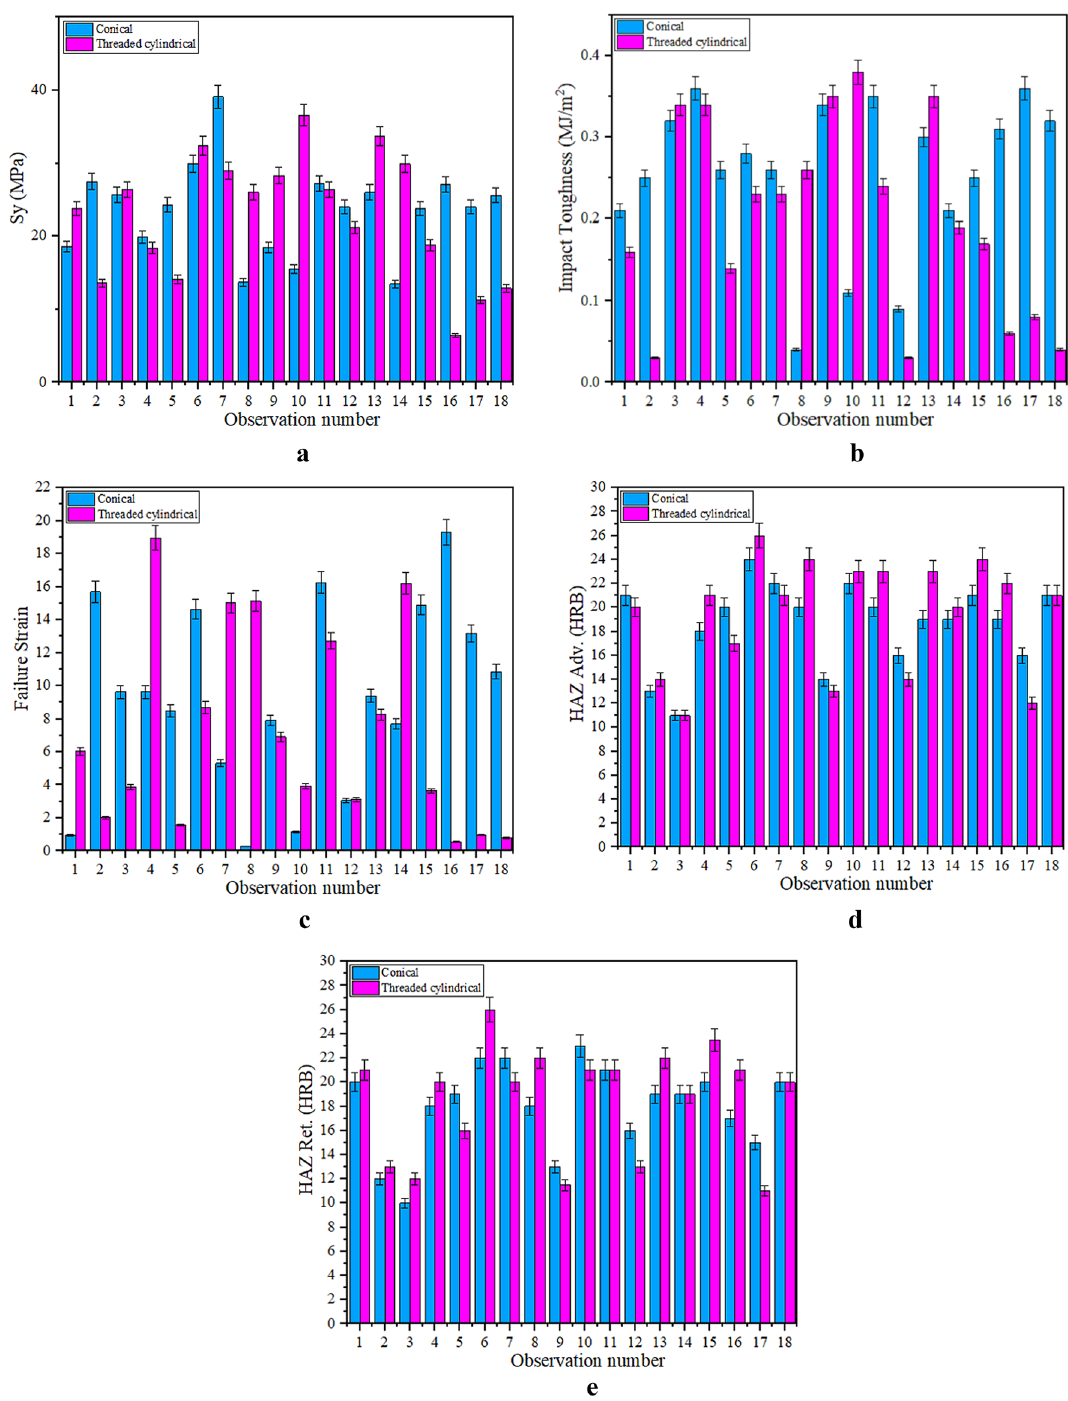
Figure 8. Results of the tensile test and hardness measurement of welded specimens with threaded cylindrical and conical pins: ( a ) yield strength, ( b ) impact toughness, ( c ) failure strain, ( d ) hardness on HAZ adv., and ( e ) hardness on HAZ